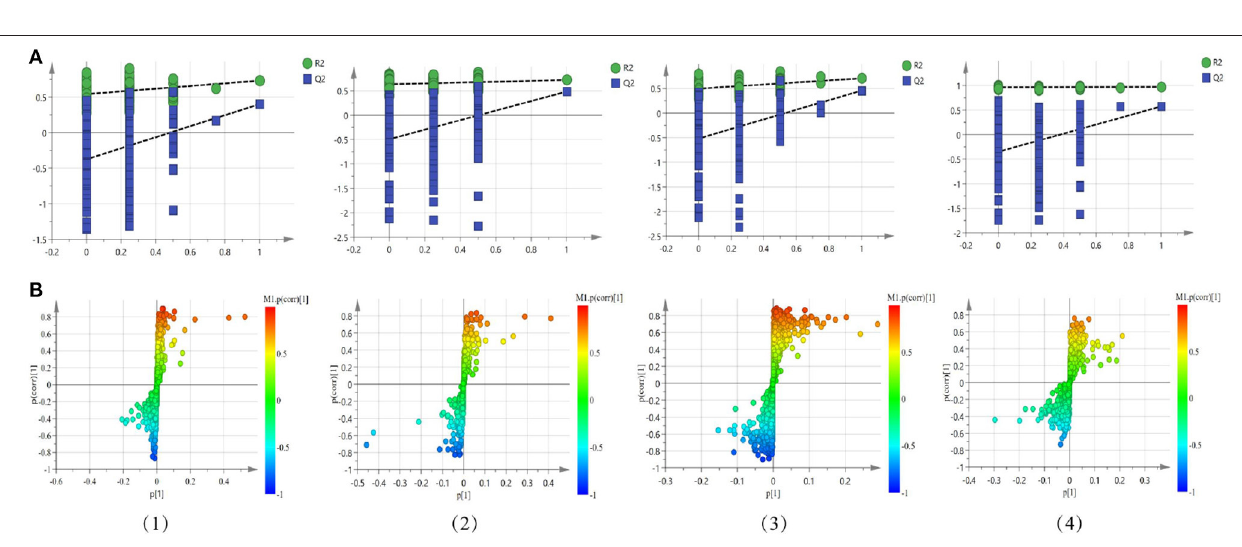
FIGURE 6 | Permutation test plots (A) and S-plot (B) of OPLS-DA between the normal group and the model group in the positive mode of the non-polar part (1) and the positive mode of the polar part (2) of the serum, and in the positive mode of the non-polar part (3) and the positive mode of the polar part (4) of the cerebral